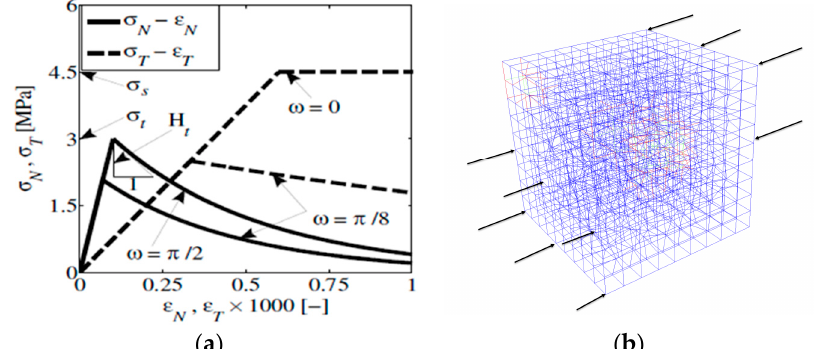
Figure 6. ( a ) Typical stress–strain curves at the LDPM facet according to Cusatis [16]; and ( b ) pure shear lattice model.